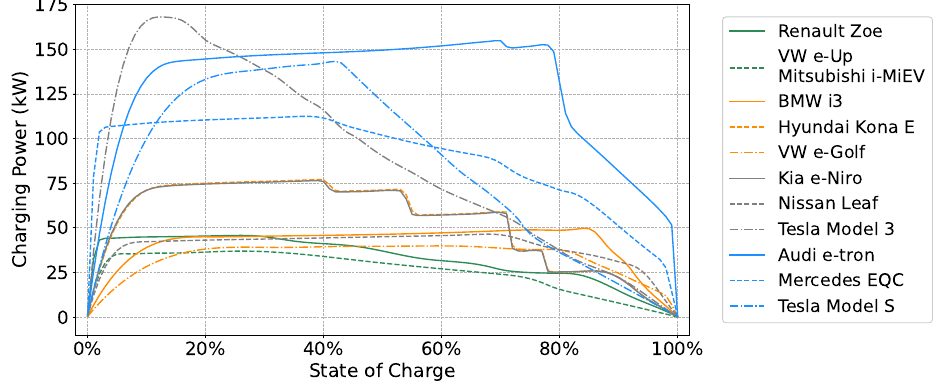
Figure A1. Charging curves of the reference vehicles